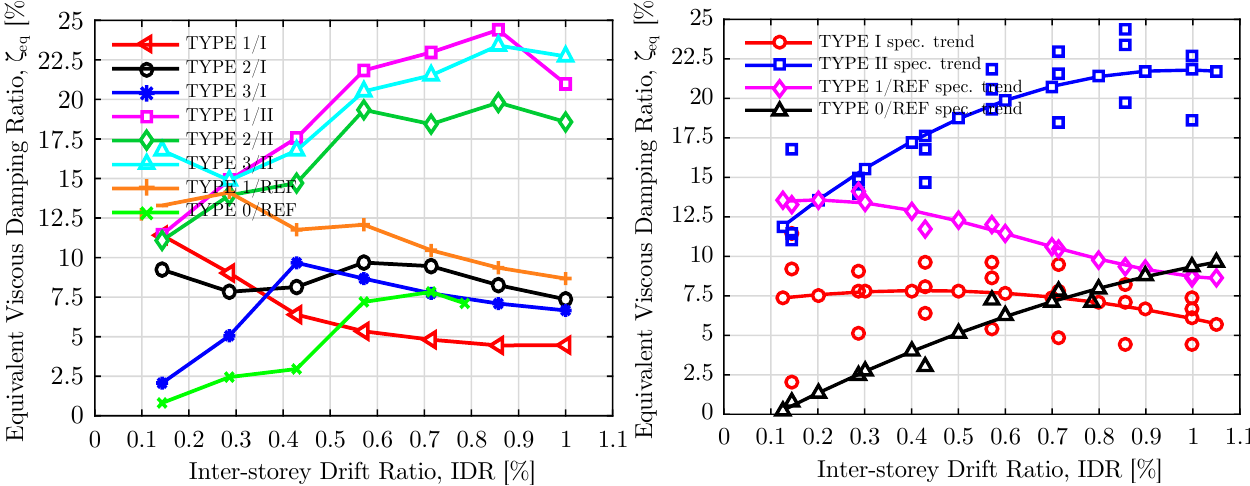
Figure 11. Equivalent viscous damping ratios ( left ) and their average trend lines ( right ). Figure 11 shows the equivalent viscous damping ratios calculated using Equation (1) for all specimens (left) and their trend lines for different types of masonry units (right). The